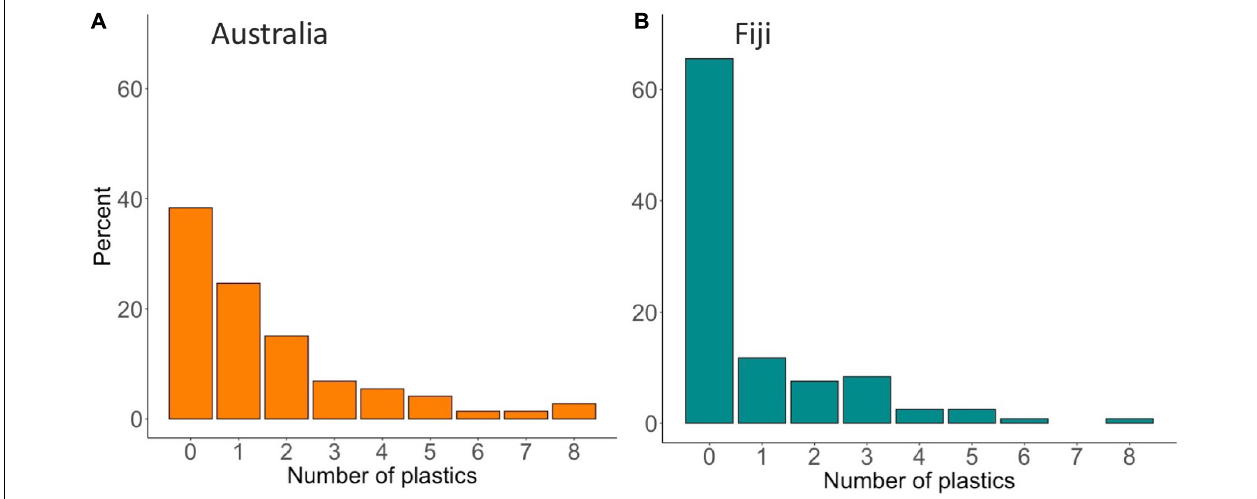
FIGURE 3 | Percentage of the total count of plastics found in the gastrointestinal tract of individual fish from (A) Australia ( n = 73 fish) and (B) Fiji ( n = 120 fish).